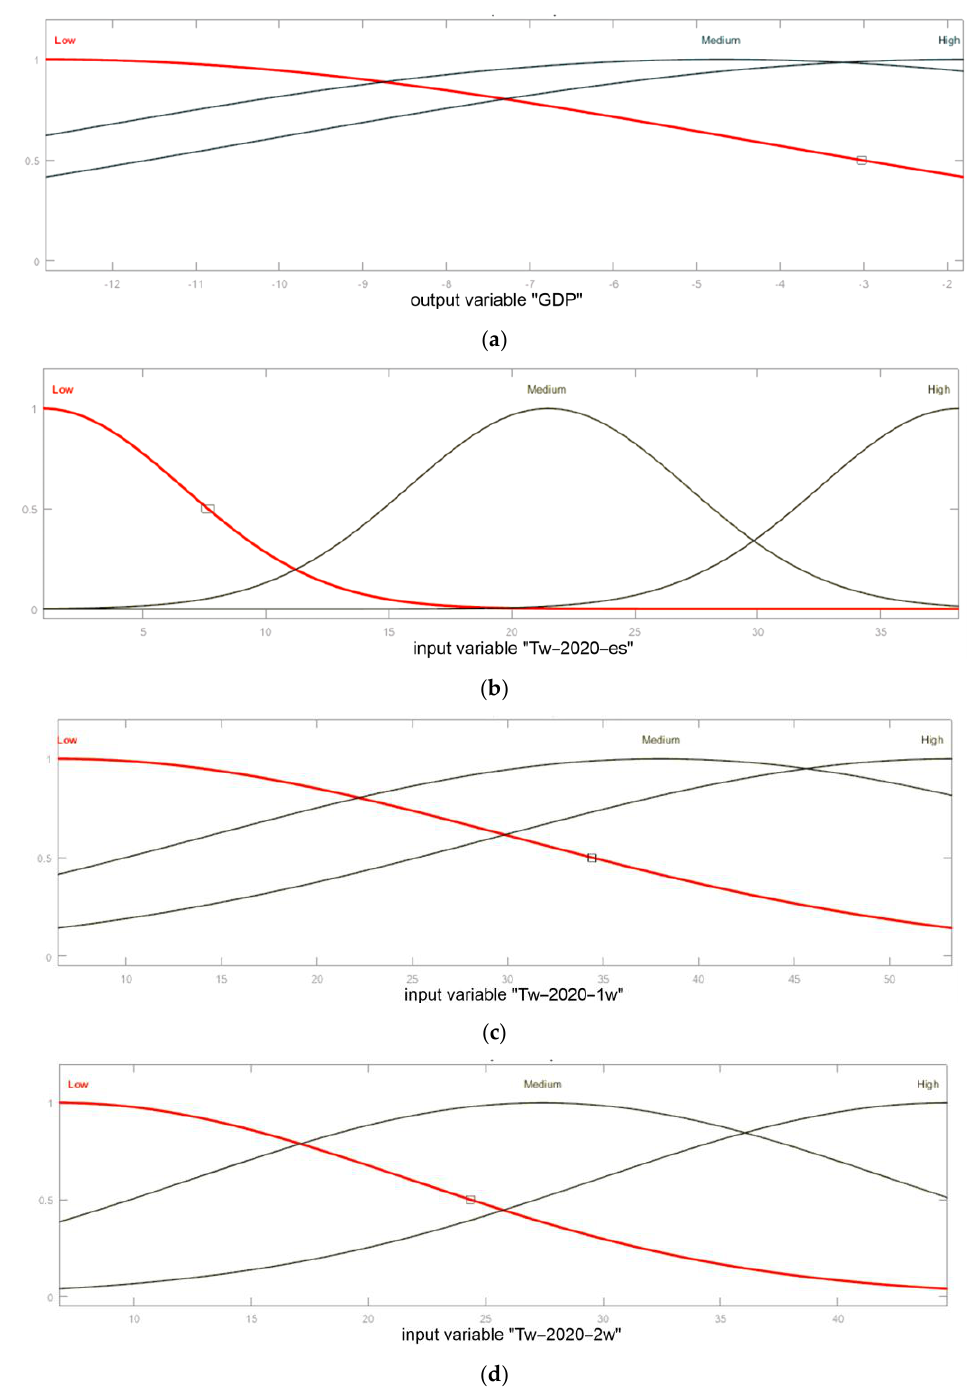
Figure 7. Membership function of GDP growth ( a ) based on Tw – es ( b ), Tw – 1w ( c ), Tw – 2w ( d ). This Gaussian membership function [101] was used due to its normal distribution and because it is similar to human reasoning. For each variable included in the presented models, their distribution for each category is presented as follow: